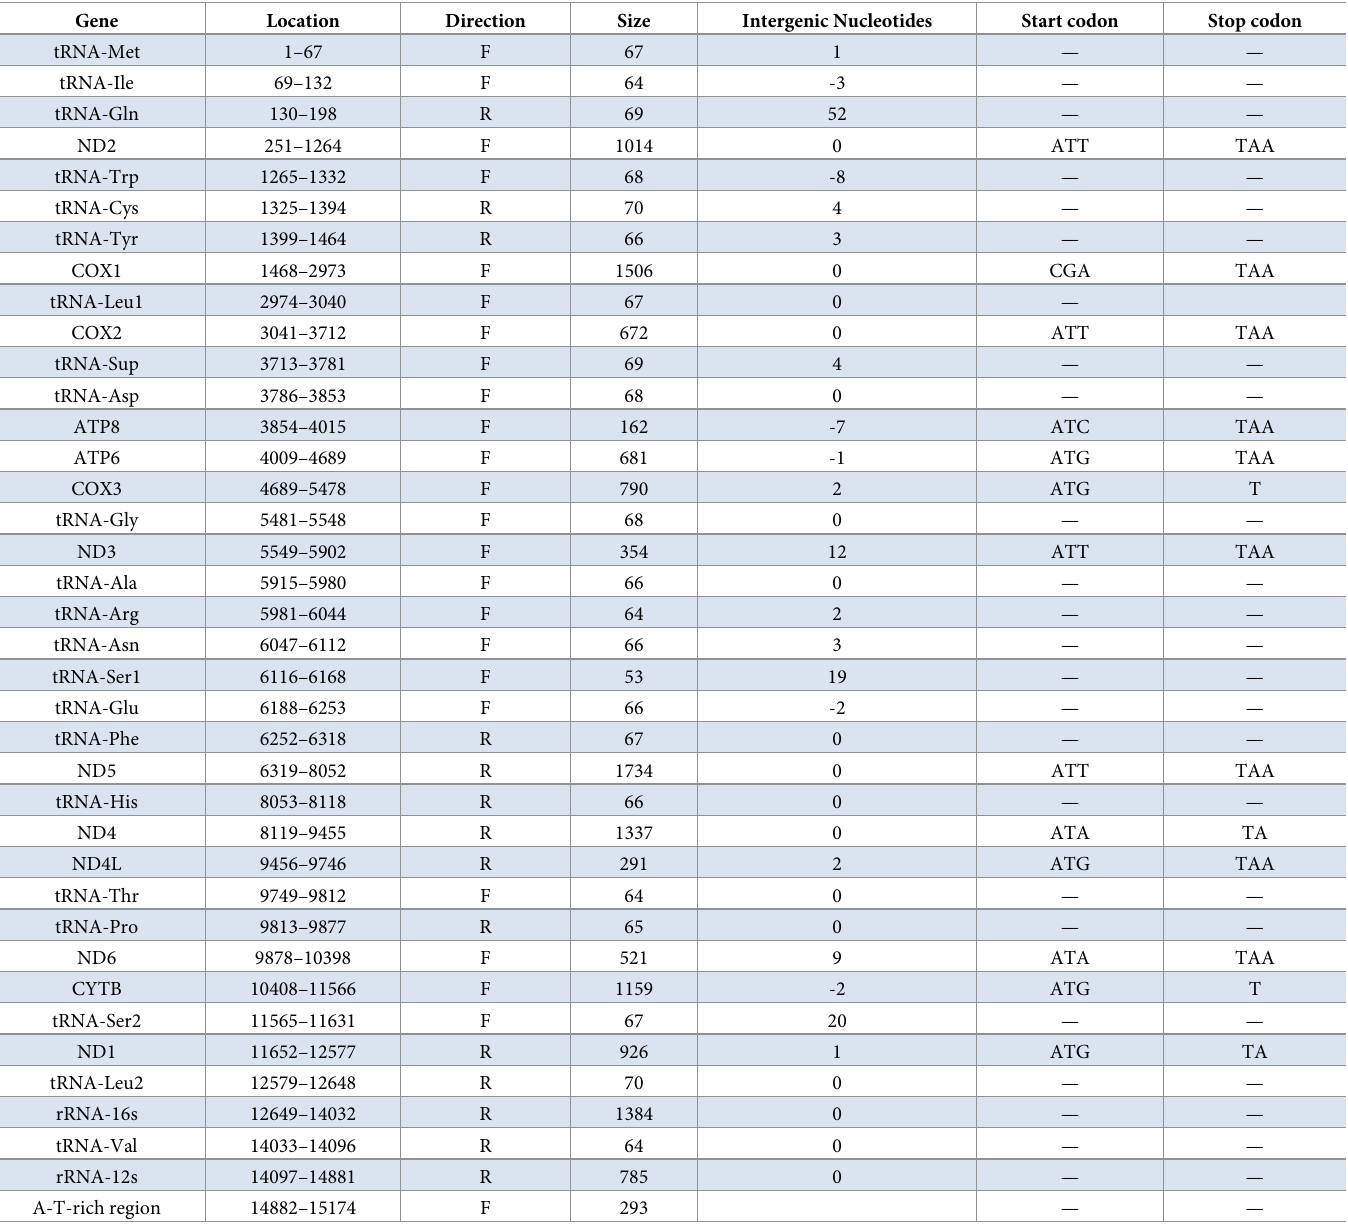
Table 3. Summary results for characteristics of the mitogenome of Orthaga olivacea Warre.